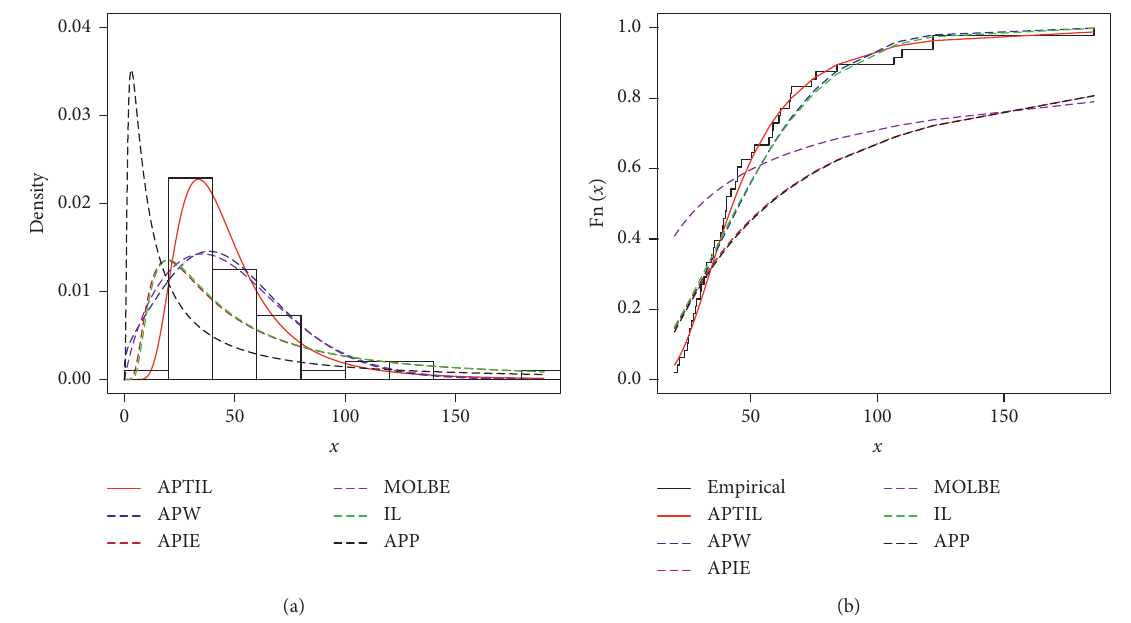
Figure 5: Estimated pdf and cdf of the APTIL model and other competing models for first data.